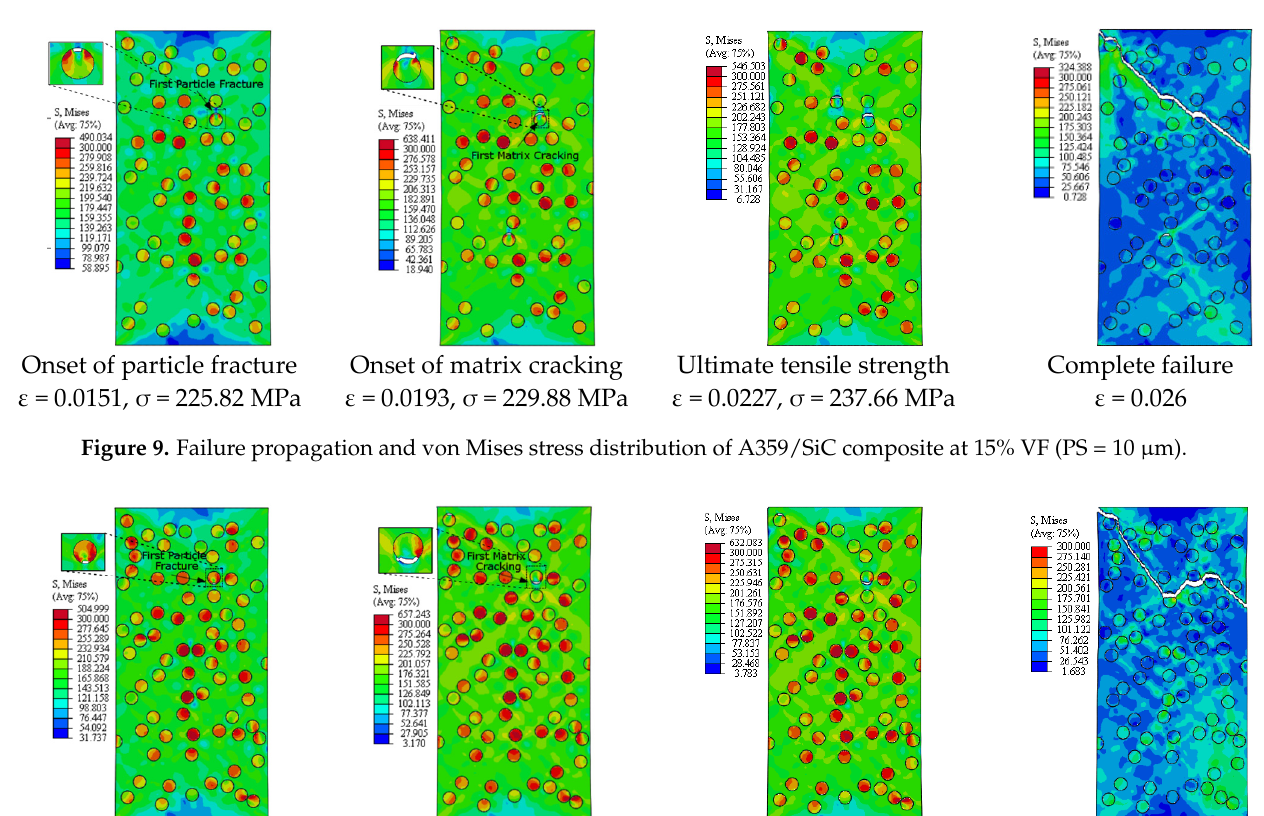
Materials 2021 , 14 , x FOR PEER REVIEW Figure 10. Failure propagation and von Mises stress distribution of A359/SiC composite at 20% VF (PS = 10 µm). Figure 10. Failure propagation and von Mises stress distribution of A359/SiC composite at 20% VF (PS = 10 µm). Figure 10. Failure propagation and von Mises stress distribution of A359/SiC composite at 20% VF (PS = 10 µ m).